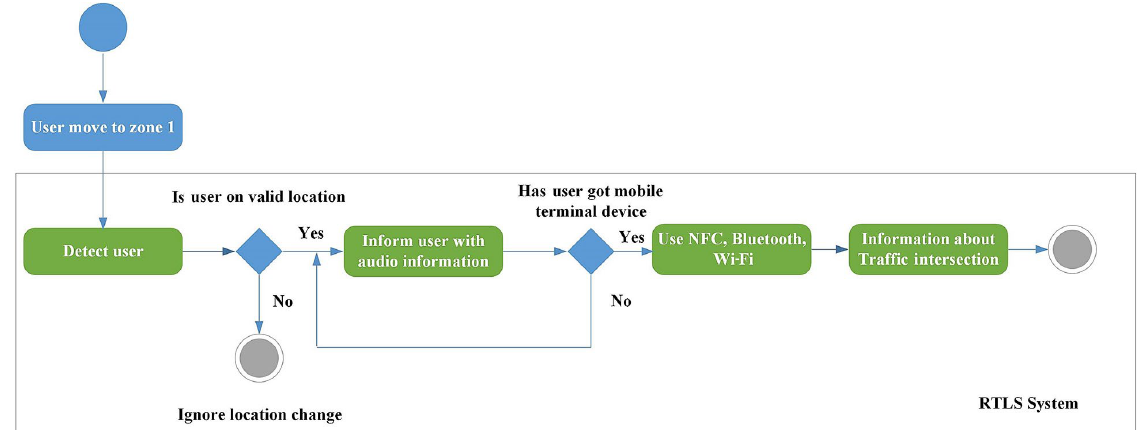
Fig. 6. System architecture for information and identification